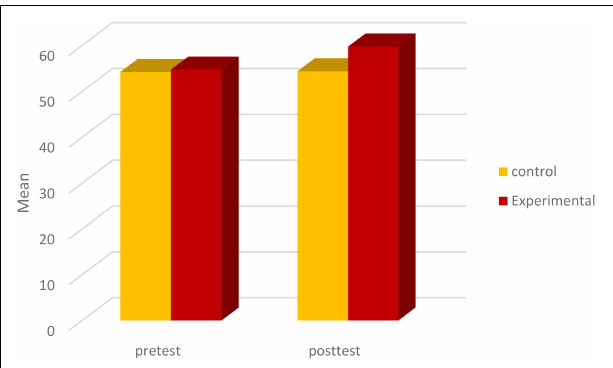
FIGURE 1 | The mean of the scores of WTC between learners in pre-test and post-test.